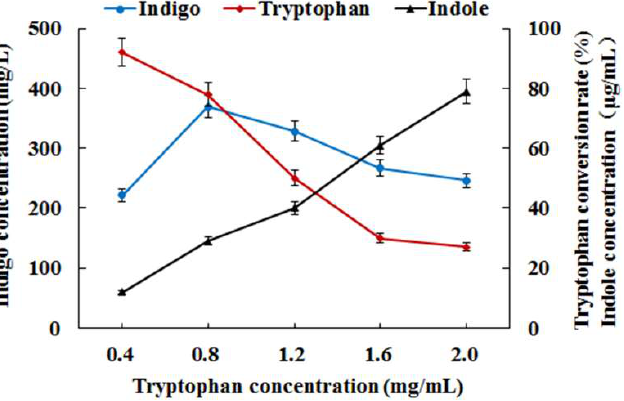
Figure 6. Indigo biosynthesis from different concentrations of tryptophan in E. coli ABT fermenta- tion.